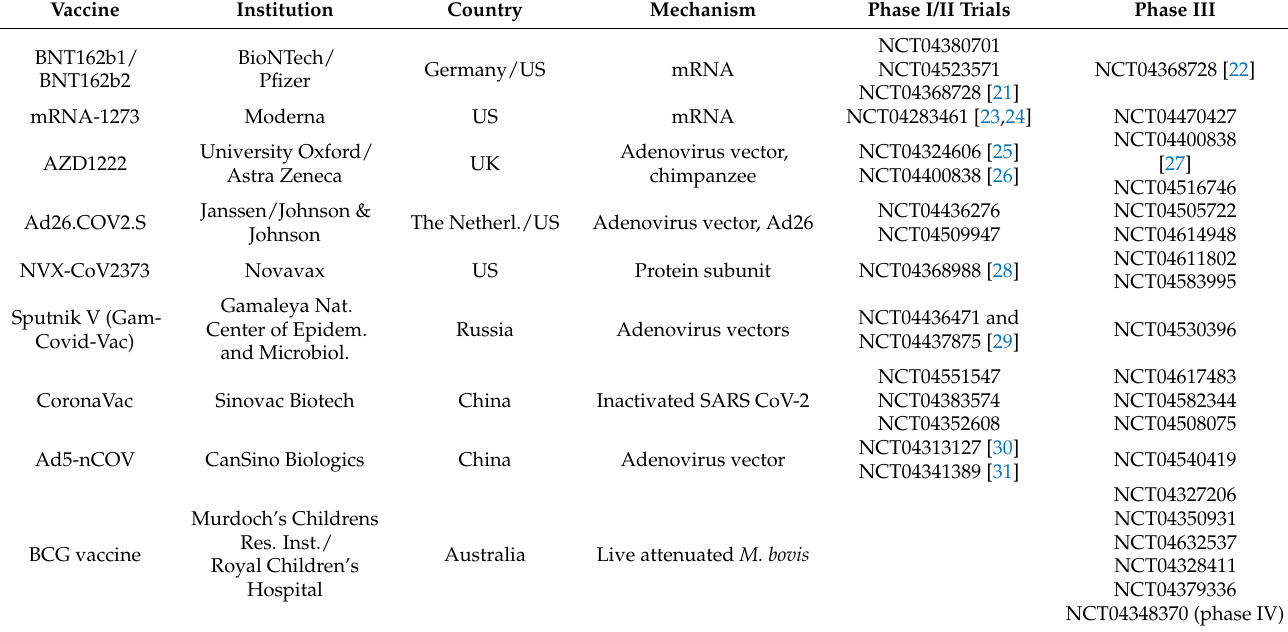
Table 1. Comparison of nine vaccines that are currently in phase III